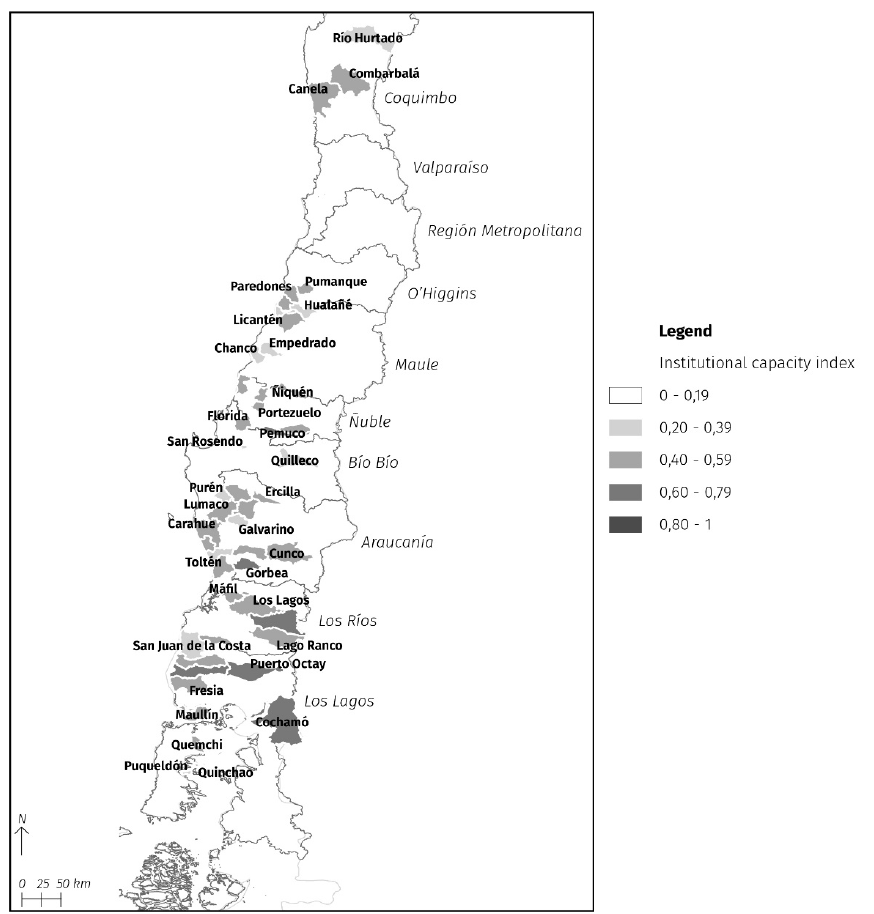
Figure 2: Institutional capacity of ageing municipalities in